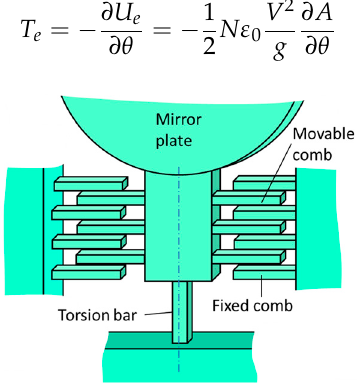
Figure 1. Schematic diagram of torsion-bar with electrostatic spring consisting of comb electrodes.